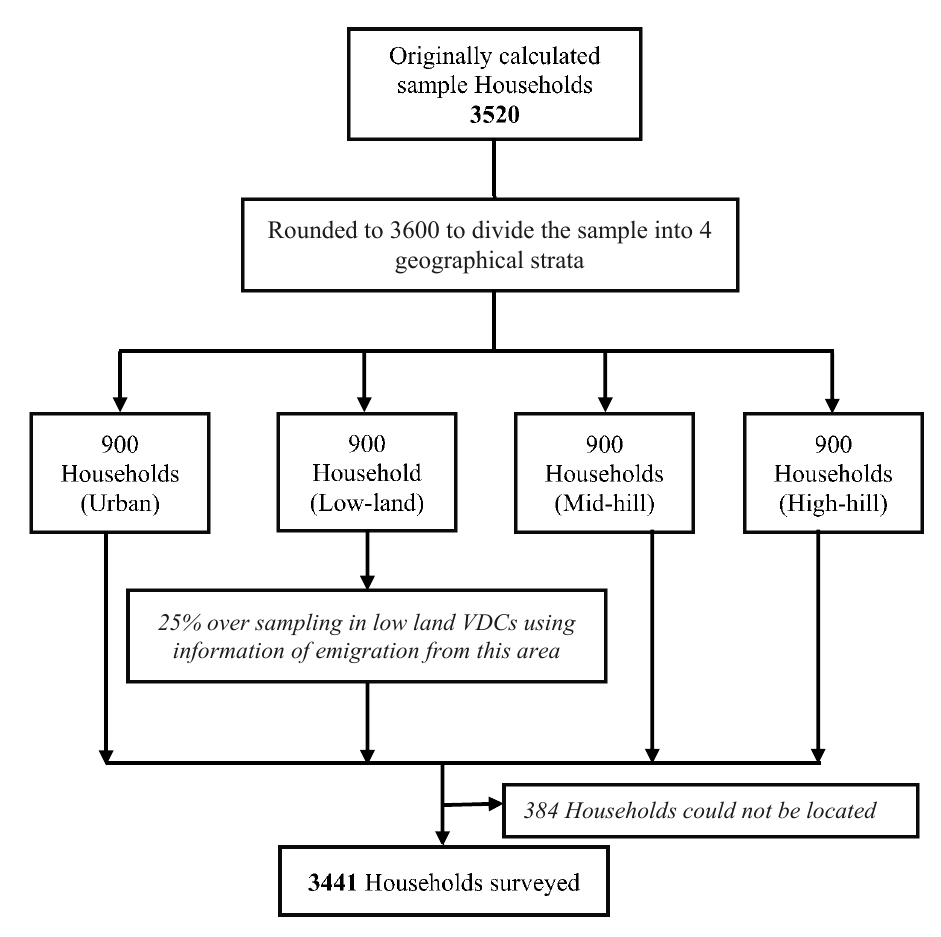
Figure 1. Flowchart of the sampling and household selection.